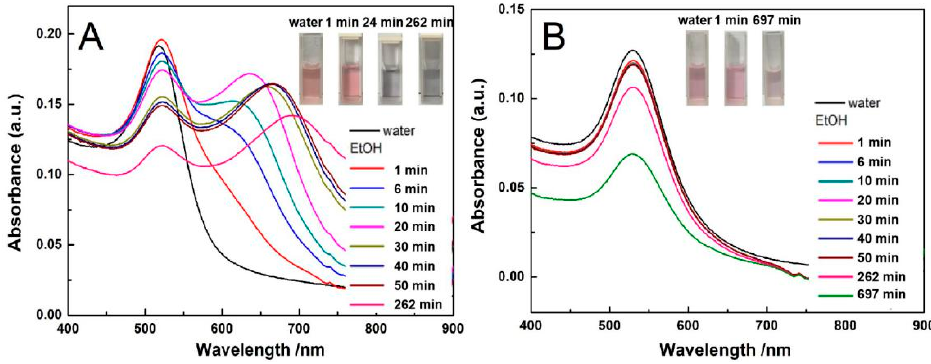
Figure 10. The change in Uv-vis spectra with time for AuNPs ( A ) and Au-PNIPAM ( B ) in ethanol medium.